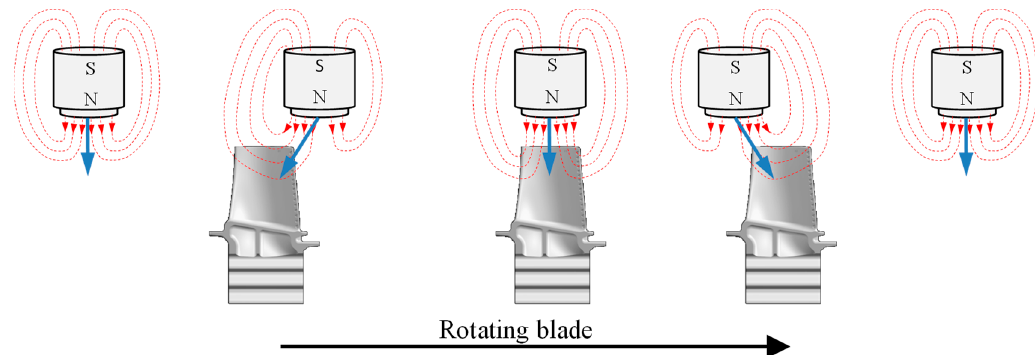
Figure 13. Function of a magnetoresistive sensor.